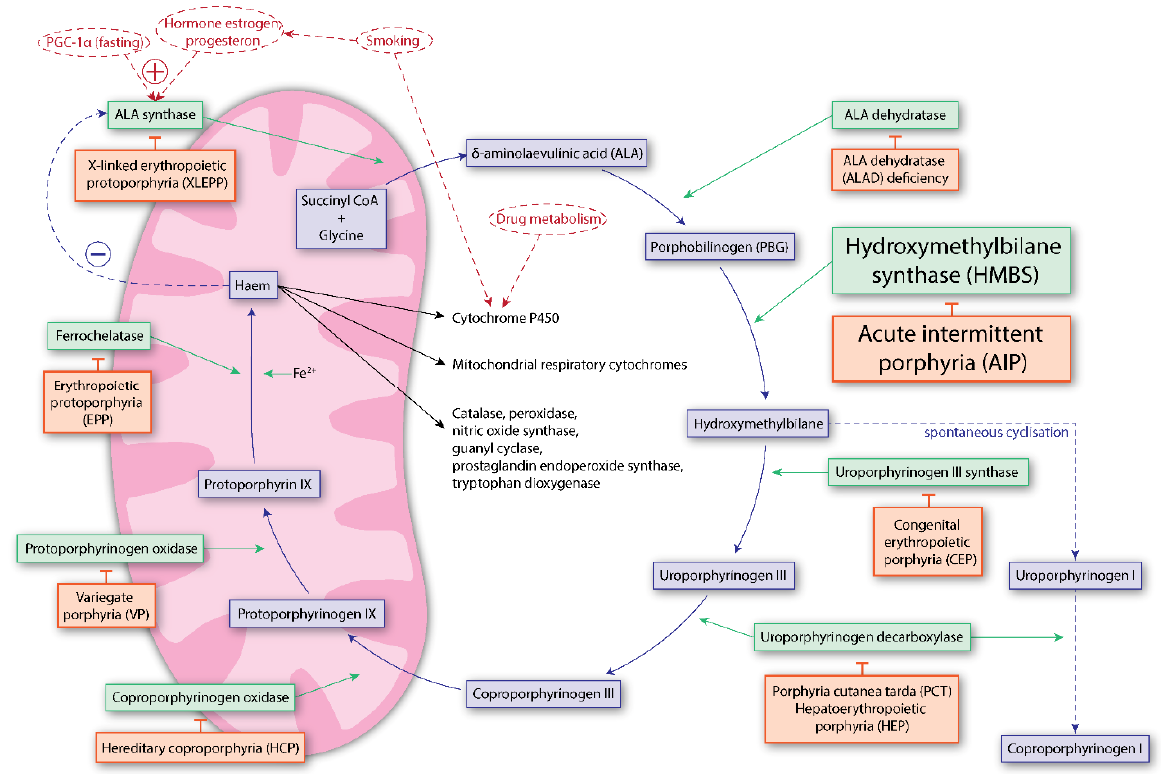
Figure 1. The haem biosynthetic pathway and associated porphyria disorders. In mammals, haem is synthesised in all nucleated cells through eight enzymatic steps and is essential for life. Each of the porphyrias (orange boxes) is caused by partial deficiency of the associated haem biosynthesis enzyme (green boxes), except for X-linked erythropoietic protoporphyria (XLEPP), which is caused by gain-of-function mutations of the erythroid-specific δ -aminolaevulinic acid synthase 2 ( ALAS2 ) gene. ALAS1, the housekeeping enzyme, is expressed in all other tissues. ALAS1 is under negative feedback control by haem (dashed blue line, left) and is rate-limiting under normal circumstances, when the catalytic capacities of the other enzymes in the pathway are normal. Drugs and hormonal factors have been identified as the most common precipitating factors for an acute attack (dashed red lines and sites of impact) [6]. Non-enzymatic and spontaneous cyclisation of hydroxymethylbilane to uroporphyrinogen I is an alternative path in cases of deficient uroporphyrinogen III synthase activity (dashed blue line, right). Figure modified from [7] and [8] .